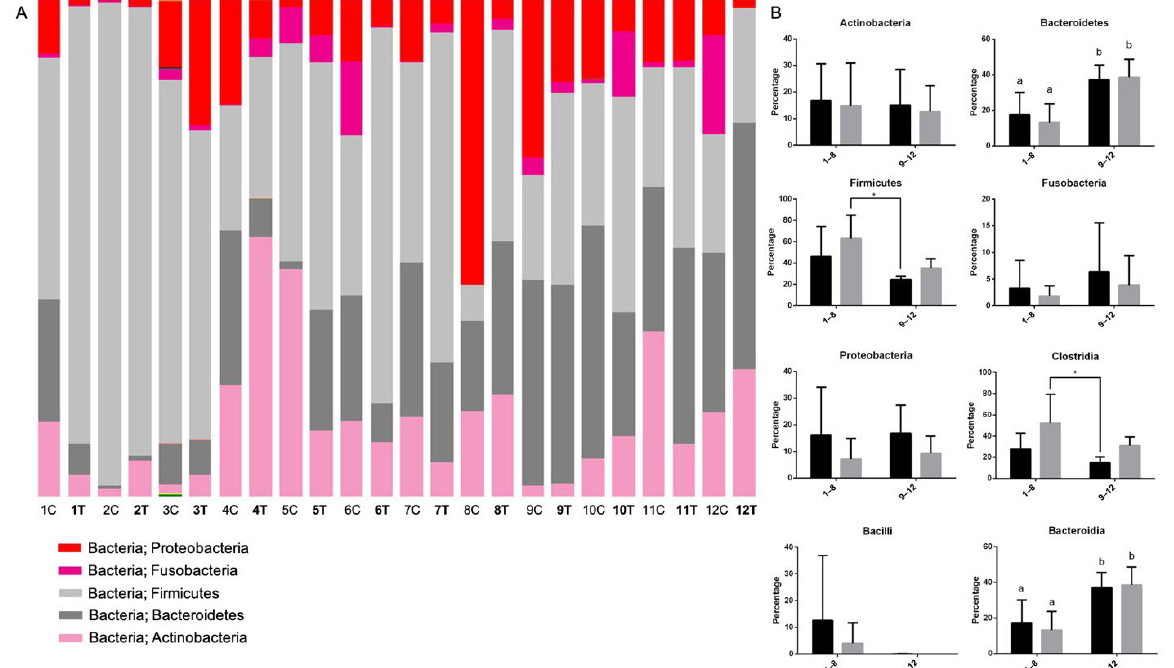
Figure 3. ( A ) Relative distribution of the bacterial phyla of the fecal microbiome in the eight cats (No. 1–8) of the treatment group and the four cats (No. 9–12) of the control group before and after the treatment of Bacillus licheniformis -fermented products (BLFP). ( B ) Comparisons of the dominant phyla and class component between in the treatment (No. 1–8) group before and after the treatment with BLFP and in the control group (No. 9–12) without BLFP treatment. Black bar: before having BLFP in the treatment group or first sampling of feces in the control group. Grey bar: after having BLFP in the treatment group or second sampling of feces in the control group. * indicates p < 0.05. A total of 87 classes were identified in all the OTUs. The relative distribution, bar chart of average percentage, and the detailed percentage of the bacterial classes are shown